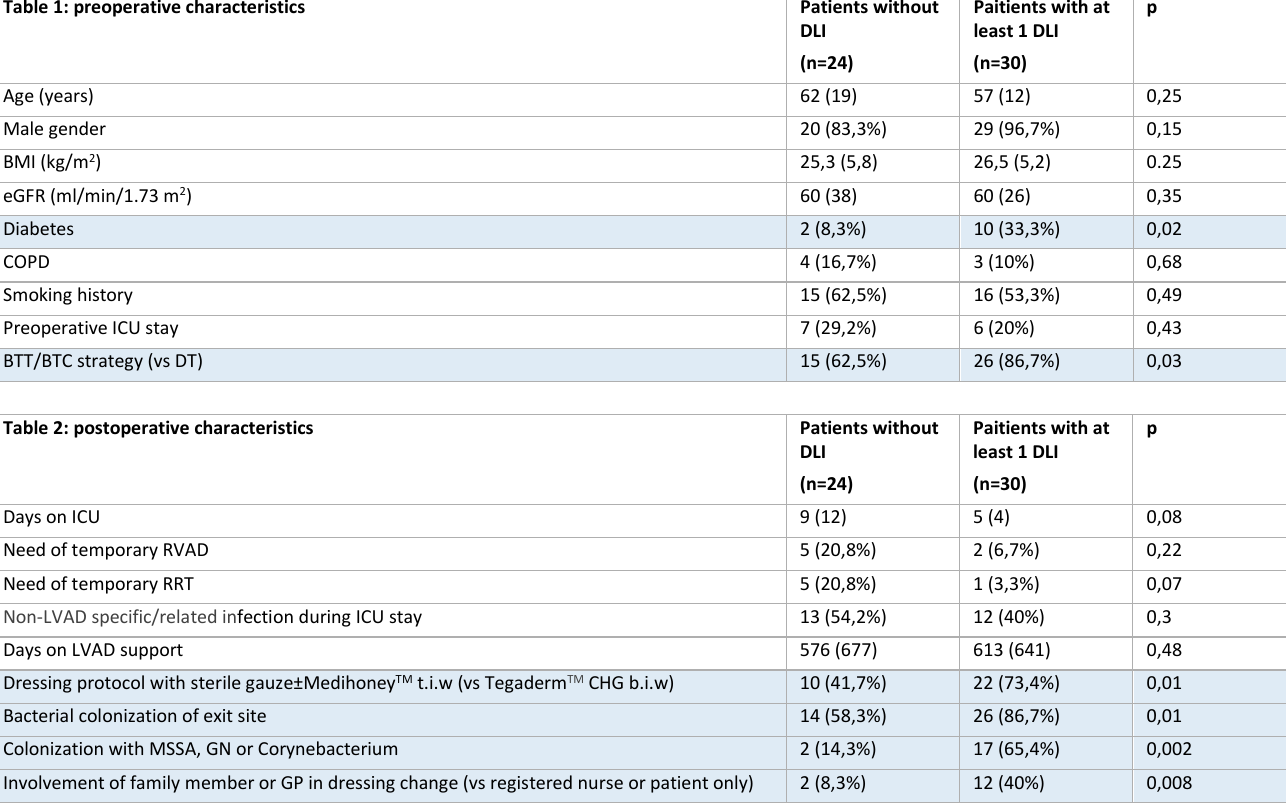
Table 1: preoperative characteristics